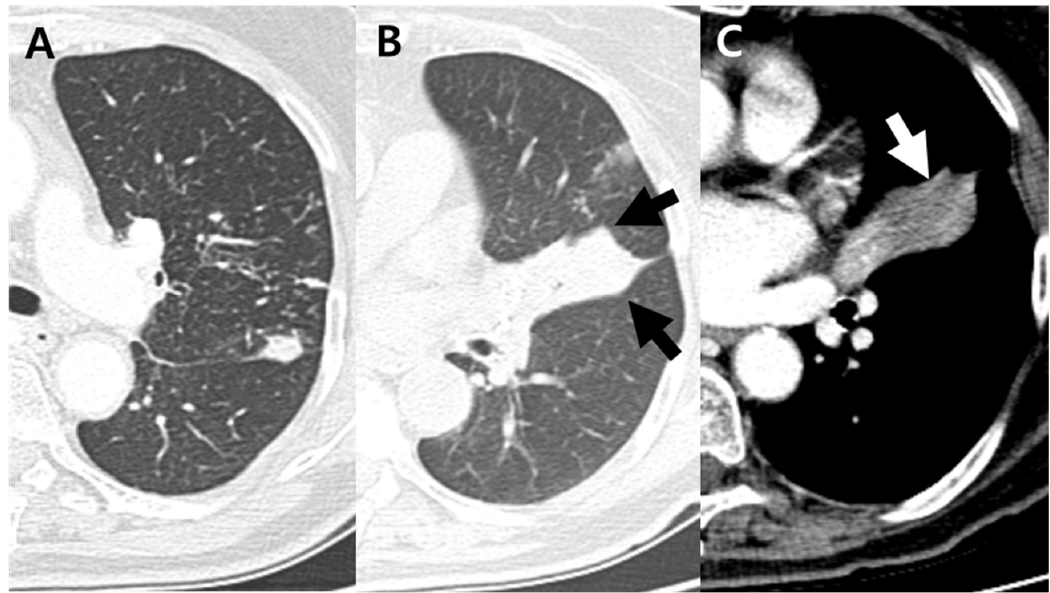
Figure 3. A 75-year-old woman with pulmonary tuberculosis and underlying bronchial anthraco- fibrosis presented with cough and sputum. ( A ) Axial CT scan showed clustered micronodules and consolidations in left upper lobe. These findings were well known typical CT findings of pulmonary tuberculosis. ( B , C ) Axial CT scan showed complete obstruction of lingular divisional bronchus, re- sulting in atelectasis with focal contour bulge (black arrows) and internal low-density area (white arrow). These findings were atypical CT findings of pulmonary tuberculosis, which cannot be sus- pected of TB. CT = computed tomography